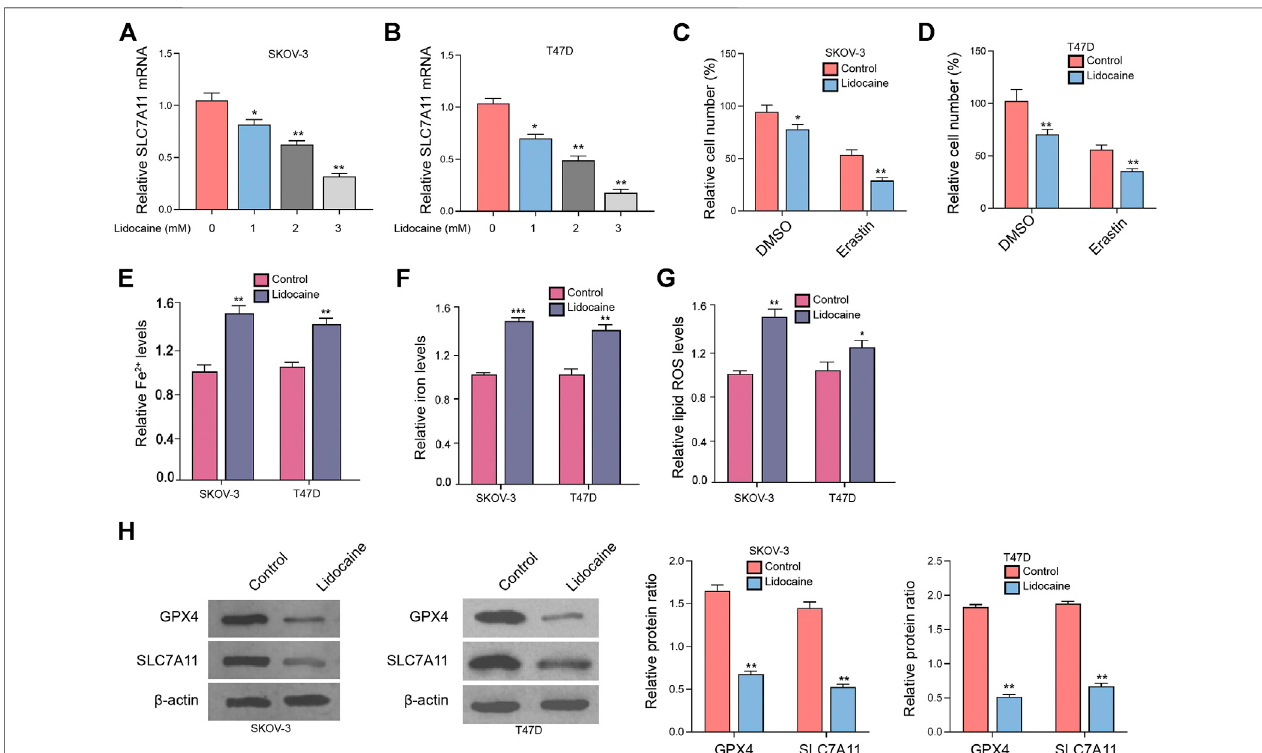
FIGURE 1 | Lidocaine induces ferroptosis of ovarian and breast cancer cells. (A,B) SKOV-3 and T47D cells were treated with lidocaine at the indicated concentrations.ThemRNAexpressionofSLC7A11wasanalyzedbyqPCR. (C,D) SKOV-3andT47Dcellswereco-treatedwitherastin(5 mmol/L)andlidocaine(3 mM). The cell viability was detected by MTT assays after 48 h of the treatment. (E – H) SKOV-3 and T47D cells were treated with lidocaine (3 mM). The Fe 2+ (E) , iron (Tesfay et al., 2019), and lipid ROS levels (G) were detected. (H) The expression of GPX4 and SLC7A11 was measured by Western blot analysis. The results were quanti fi ed using ImageJ software. mean ± SD, ** p < 0.05, ** p < 0.01. The experiments were performed independently three